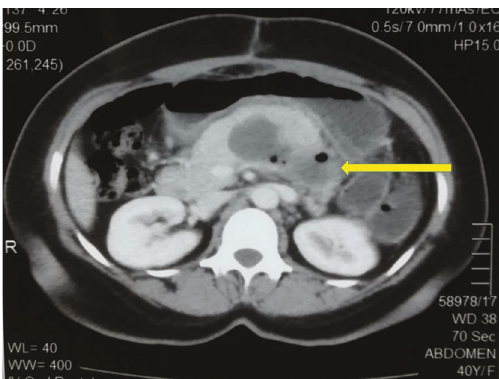
Figure 2: Postoperative computed tomography image showing a 7 × 4 : 8 × 4 : 9 cm mass lesion with a thin wall containing hypodense material, attached to the inferior border of the